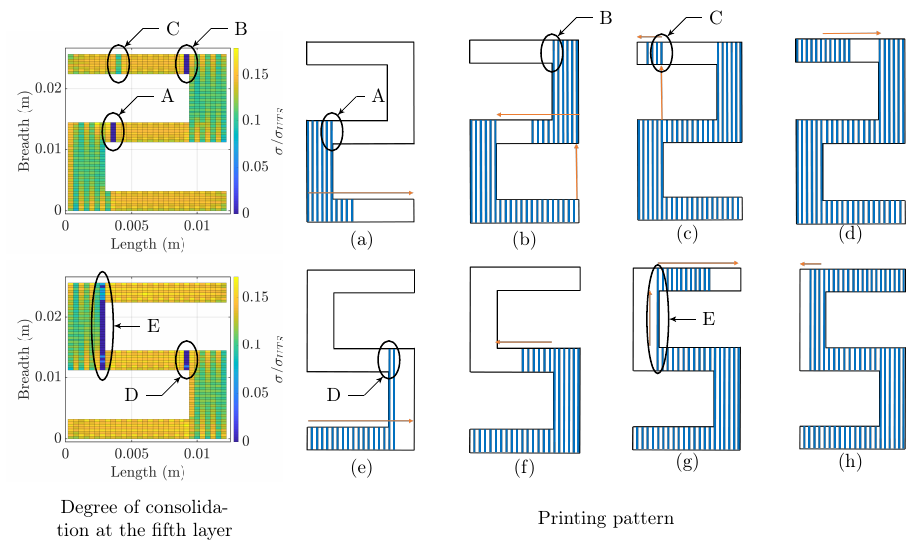
Figure 5: Effect of printing pattern over consolidation degree in similar geometry. Note : The two geometries are the same with difference lies only in the printing pattern. The first column depicts the distribution of the consolidation degree while the rest of the figure demonstrates the printing pattern. The blue lines represent the individual roads and the orange arrows direct the deposition progress (view in color). The difference in the printing pattern creates the consolidation artifacts marked by the regions A, B, C, D, and E. Panels ( a – h ) depict the details of printing pattern used.